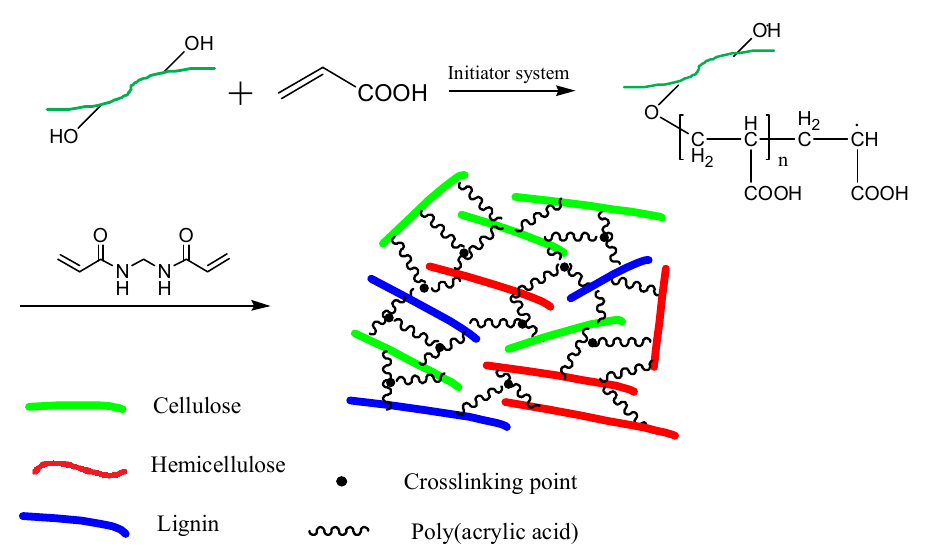
Figure 2. The preparation diagram of straw-biopolymer-based hydrogel.